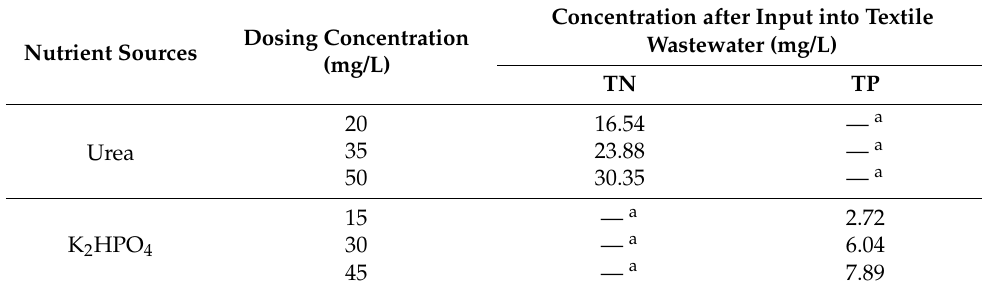
Table 4. Types of nutrient sources of